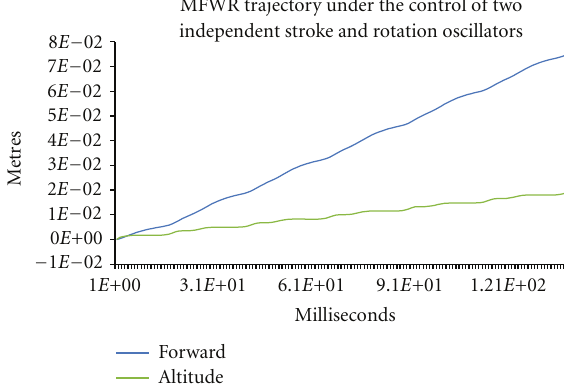
Figure 19: The trajectory of MFWR produced under the control of the amputated cruise controller. It can be noticed that the controller, with two independent oscillators for stroke, and rotation produces an acceptable cruise behavior during initial phases of the flight, but immediately loose its ability to control and reduce the altitude variations, in absence of the monitor neuron.